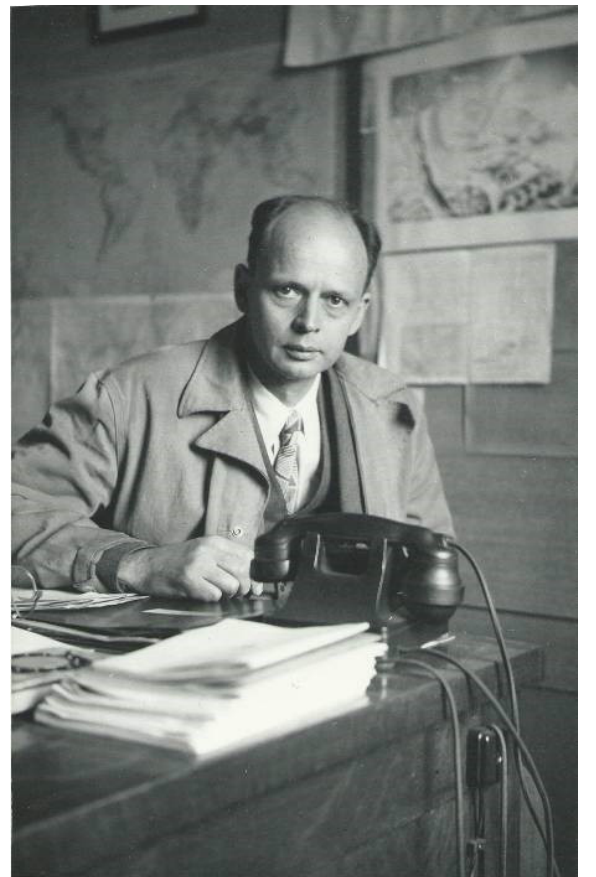
Figure 9. Casagrande, circa